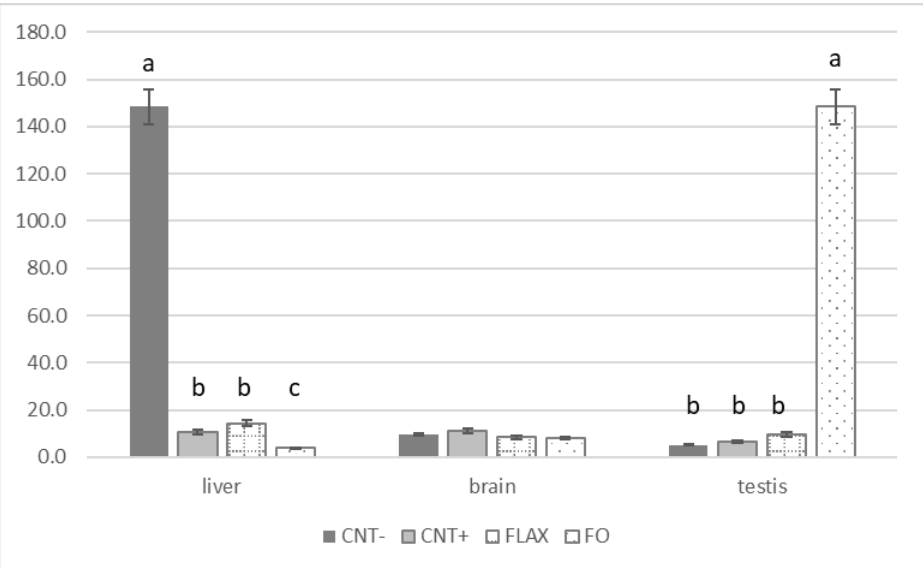
Figure 3. The effect of experimental diets on the gluthatione reduced (GSH) and oxidised (GSSG) ratio, both expressed as nmol/mg protein — in rabbit liver, brain, and testis. The bars represent least squares means + 95% upper and lower limits. The letters a – c indicate a significant difference between dietary groups ( p < 0.05, Bonferroni post hoc test).